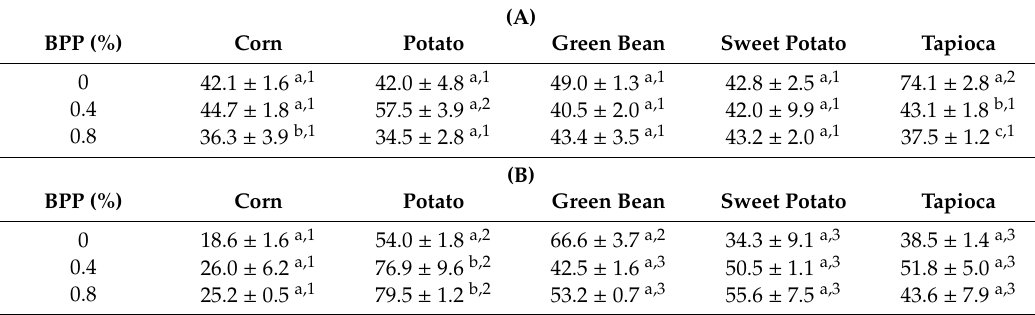
Table 3. The gloss of the support ( A ) and air side ( B ) films made from di ff erent types of starch with di ff erent starch and BPP